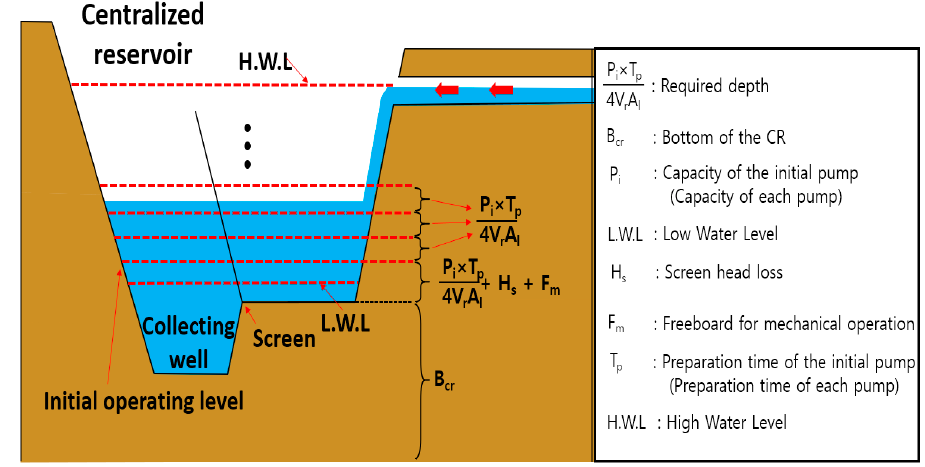
Figure 2. Determination of operating levels for drainage pumps in the centralized reservoir (CR).